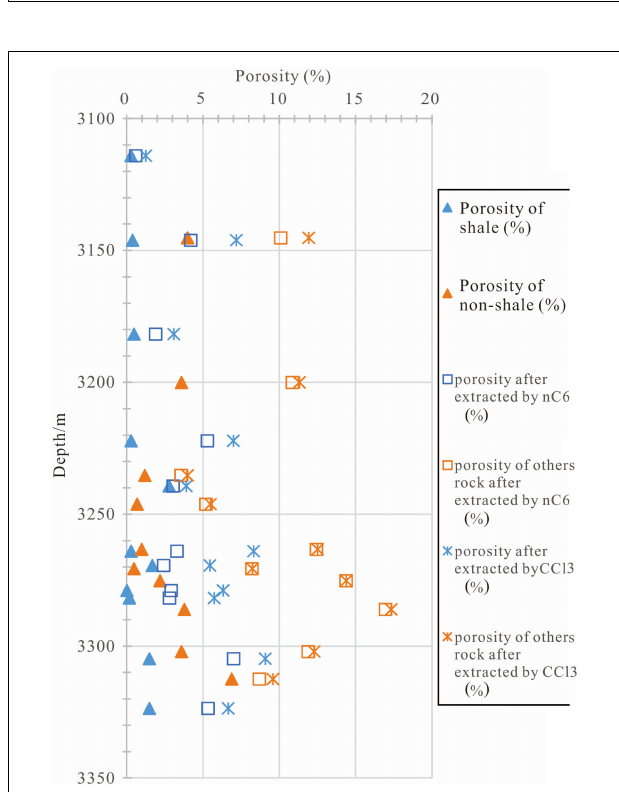
FIGURE 9 | Porosity of the mud shale samples versus the non-mud shale after extraction with nC 6 alone or with CHCl 3 alone. the viscosity), and the harder it is to extract in from underground reservoirs.